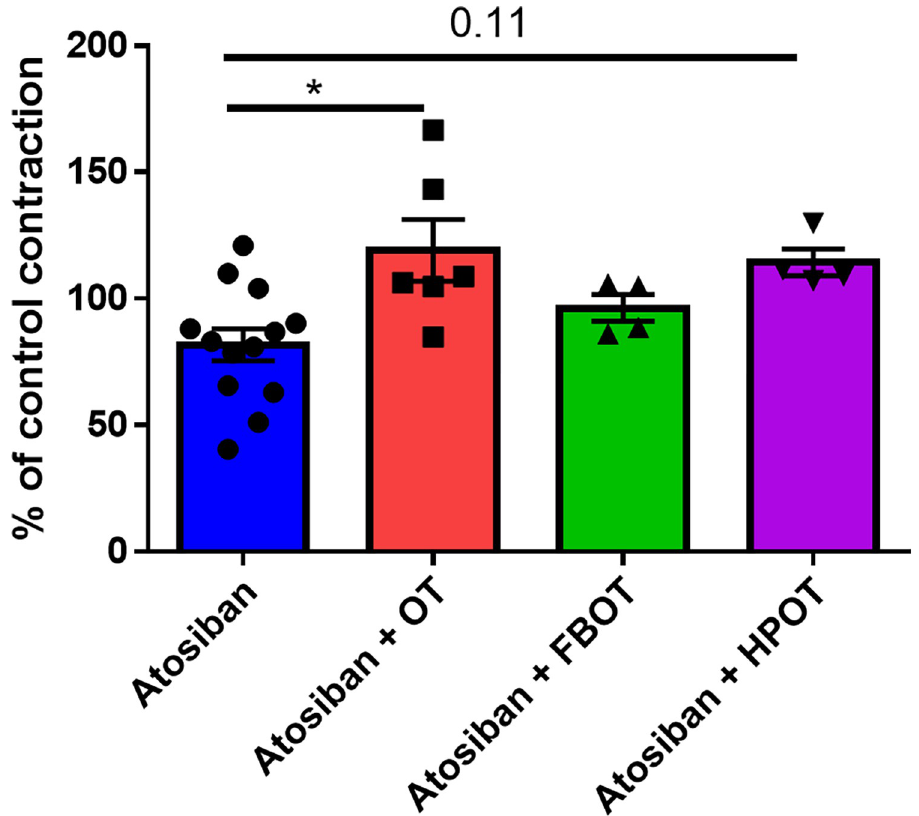
Fig 3. Recovery of ex vivo human uterine contraction by OT and its analogs after atosiban-mediated inhibition. Contractions induced by 1 nM OT (OT; n = 6), FBOT (n = 4), and HPOT (n = 4) in the presence of 1 μ M atosiban (n = 13) in 2 − 6 independent samples with duplicate measurements. Percentage of contraction was calculated using AUC. 100% represents spontaneous contraction without any treatment. Atosiban was applied 5 min before treatment with agonists. � P <